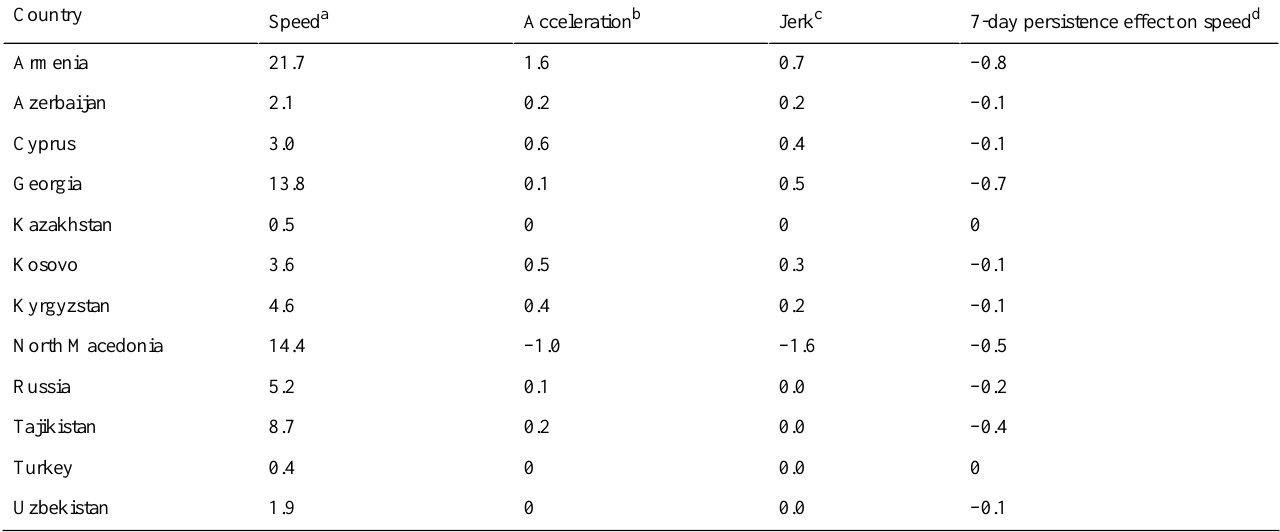
Table 5. Novel surveillance metrics for the week of October 7-13, 2020.